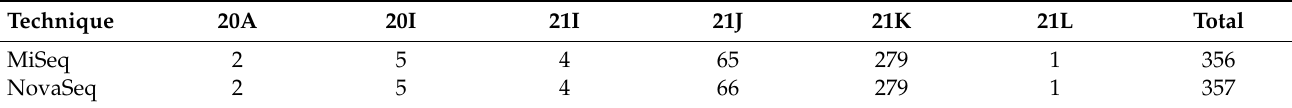
Table 2. Comparison of SARS-CoV-2 clades monitored with two sequencing protocols.